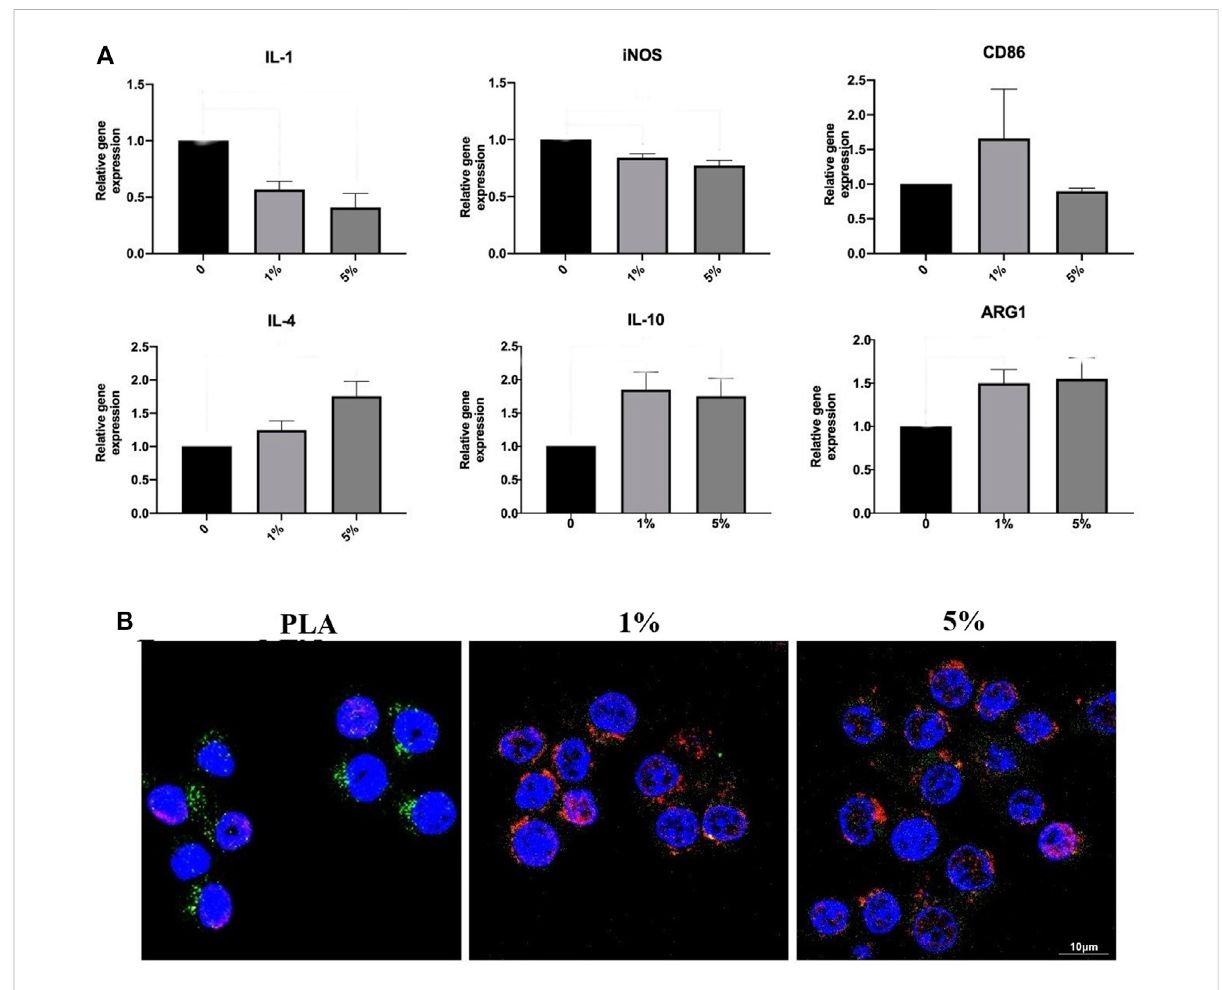
FIGURE 5 Inducing effect on macrophage polarization of cells RAW264 cultured with leaching solutions from PLA, 1% and 5% BG-PLA. (A) . RT-PCR; (B) Immuno fl uorescence.